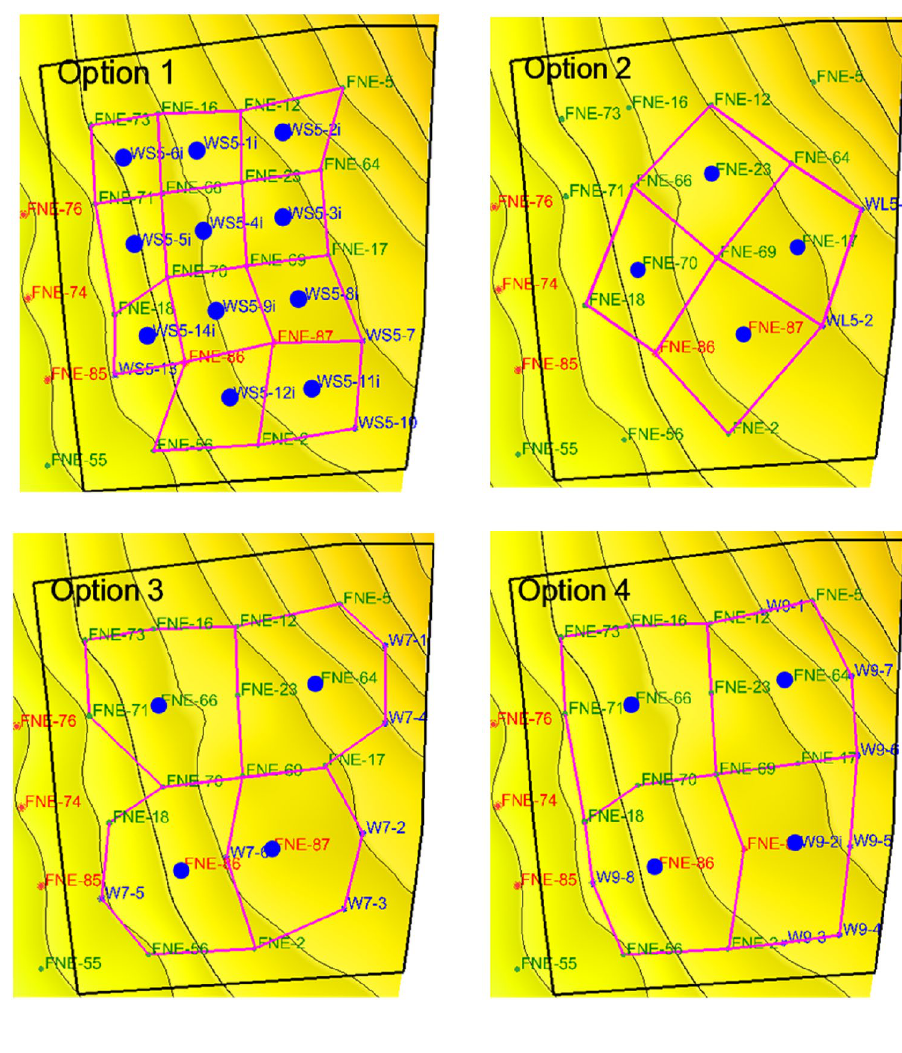
Table 3 SF designed and forecast result of each option